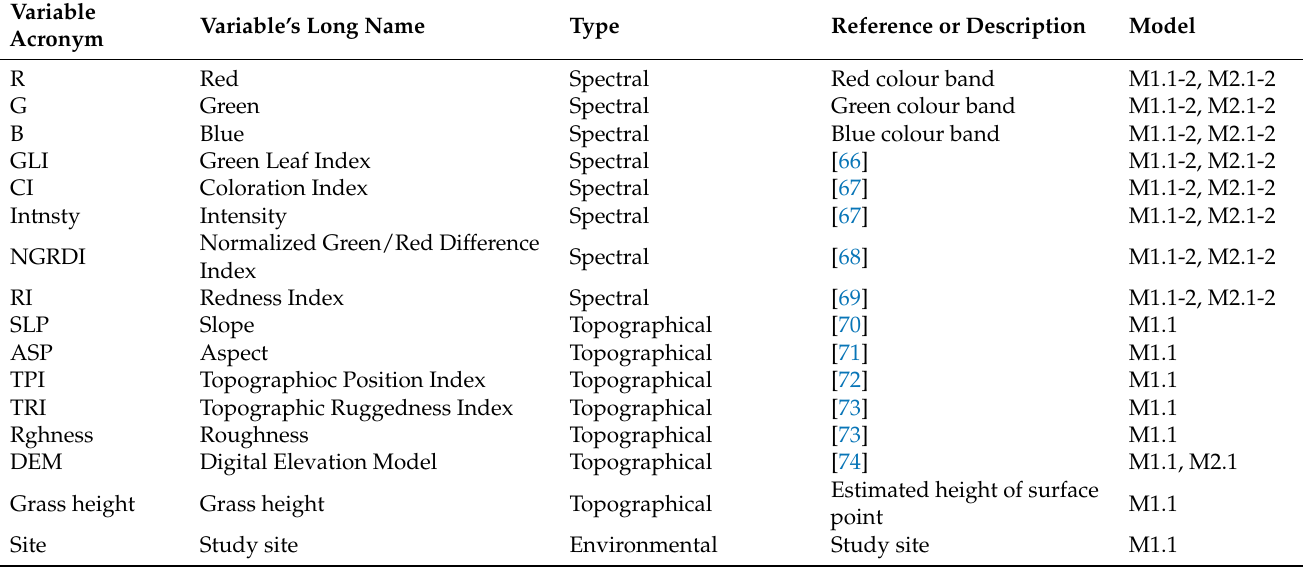
Table 1. List and descriptions of input variables (predictors) for the four RF models (M1.1, 1.2, 2.1,